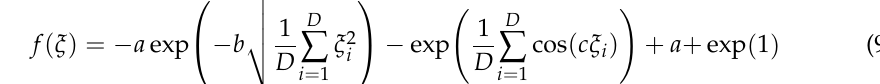
Figure 2. Model image of different functions: ( a ) Griewank function and ( b ) Ackley function. The Ackley function, which is characterized by a nearly flat outer region and a large hole at the center (see Figure 2b), is used to test the global convergence and is defined as: